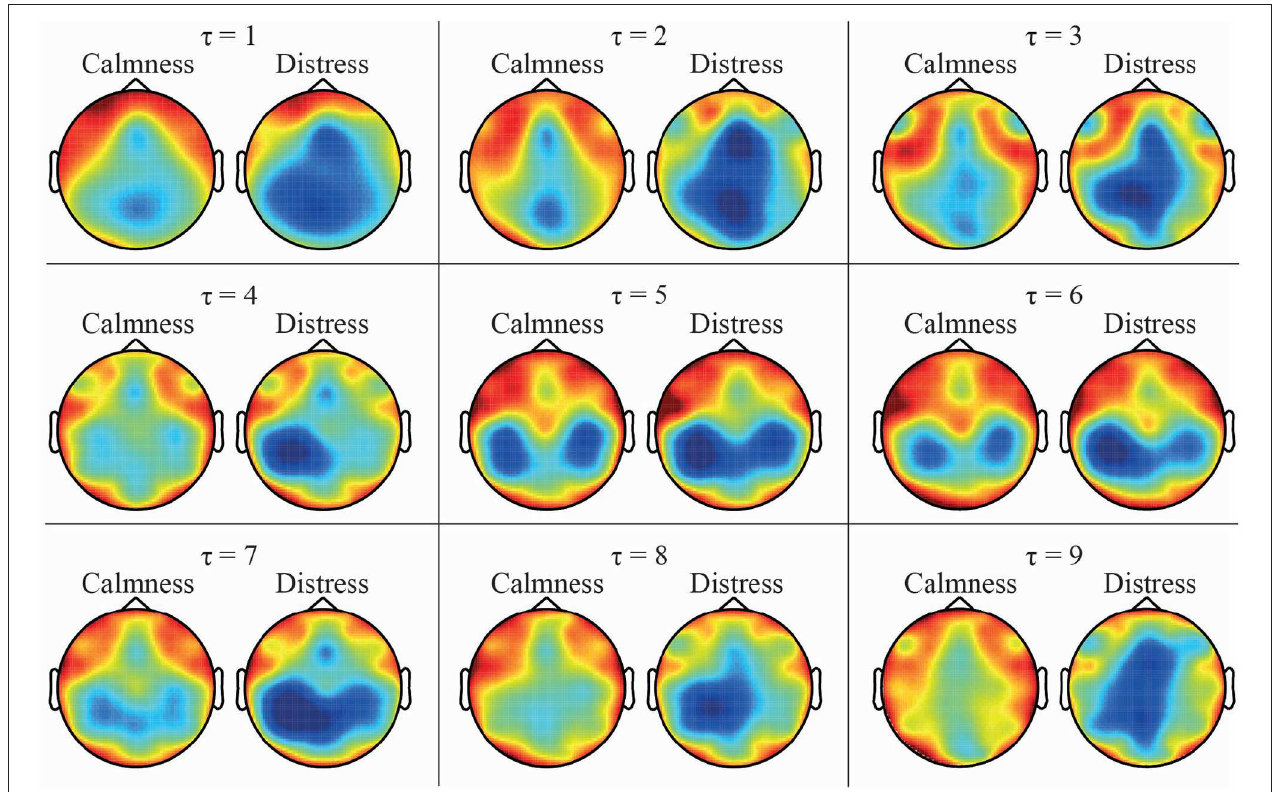
FIGURE 5 | Topological EEG representation of average calmness and distress values for time-lags from τ = 1 to τ = 9 using PME